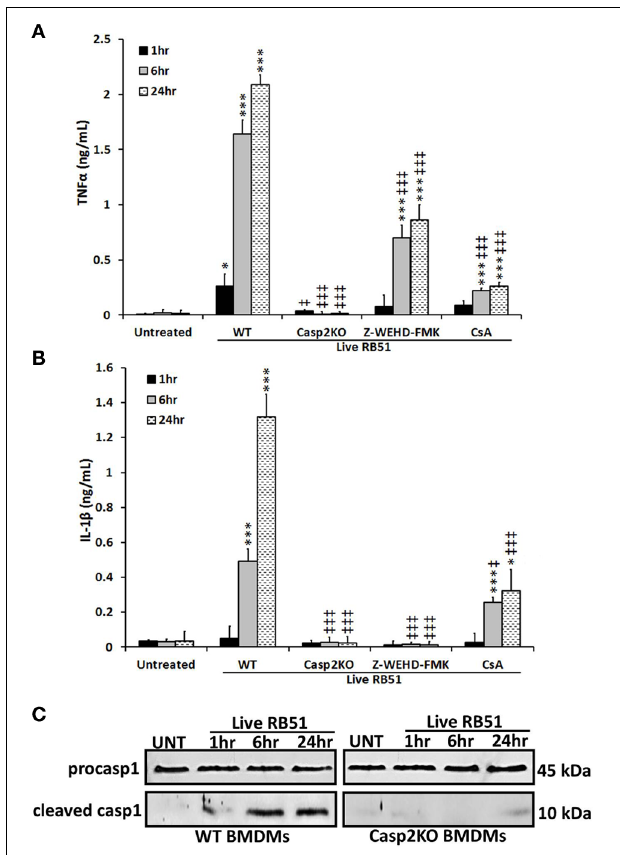
FIGURE 2 | Caspase-2 drives proinflammatory responses in RB51-infected macrophages. (A) TNF α and (B) IL-1 β levels in WT, casp2 − / − , CsA (cyclosporin A, inhibitor of mitochondrial permeability transition pore, 10 μ M) and Z-WEHD-FMK (caspase-1 inhibitor, 20 μ M) treated BMDMs. Error bars represent mean ± SD of n ≥ 3 independent experiments. ‡ , ∗ p < 0 . 01 and ‡ ‡ ‡ , ∗∗∗ p < 0 . 0001, Student’s t -test. ( ∗ , ∗∗∗ ) and ( ‡ , ‡ ‡ ‡ ) represent comparison to untreated and WT + Live RB51, respectively. (C) caspase-1 cleavage (activation) in Live RB51-infected WT and casp2 − / − BMDMs. UT represents untreated (negative control). Immunoblots are representatives of n ≥ 3 independent